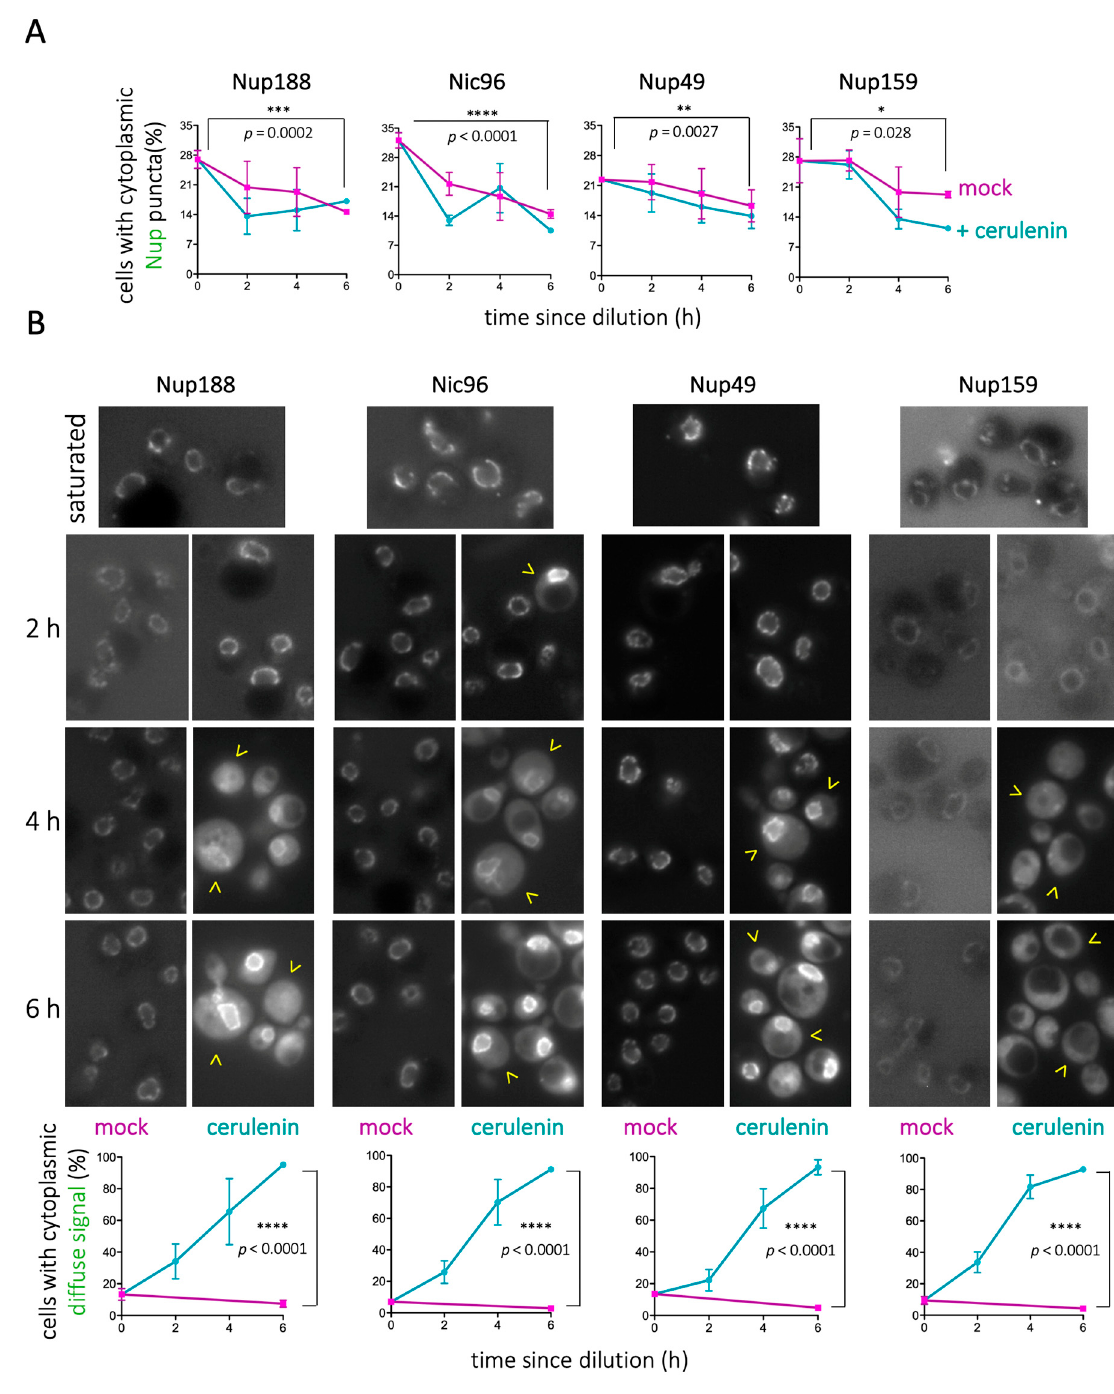
Figure 2. LD consumption by cerulenin dismantles cytoplasmic Nup puncta. ( A ) Overnight cultures grown in rich medium until saturation were diluted in the presence of 10 µ g/mL cerulenin or in its absence (mock). Quantification showing the percentage of cells in the population displaying Nup cytoplasmic foci co-localizing with LD, for the indicated Nup, at the indicated culture timepoints. ( B ) top: Representative images of the timepoints described in ( A ). Yellow arrowheads point at cells in which the fluorescent signal becomes diffuse in the cytoplasm; bottom: Quantification showing the percentage of cells in the population in which Nup signals become diffuse in the cytoplasm. The data for each Nup are represented as an individual graph, in which timepoints correspond to the elapsed time since dilution in the presence of cerulenin or in its absence (mock). Each point is the mean value of three independent experiments. The significance of the difference of the means after applying a t -test is indicated by asterisks and P-values. Bars correspond to the SEM of those three independent